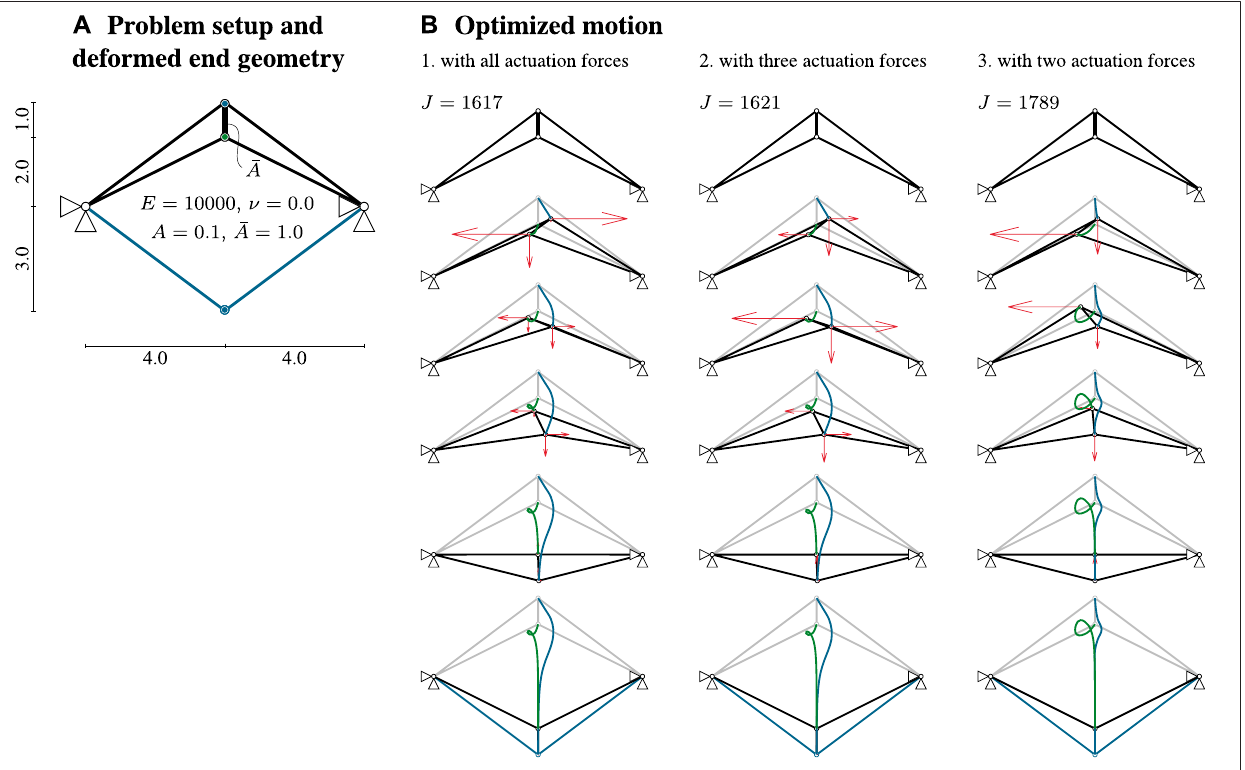
FIGURE 4 | External actuation force placement in an extended two-bar truss. (A) Problem setup amd deformed end geometry. (B) Optimized motion, 1) with all actuation forces, 2) with three actuation forces, and 3) with two actuation forces.